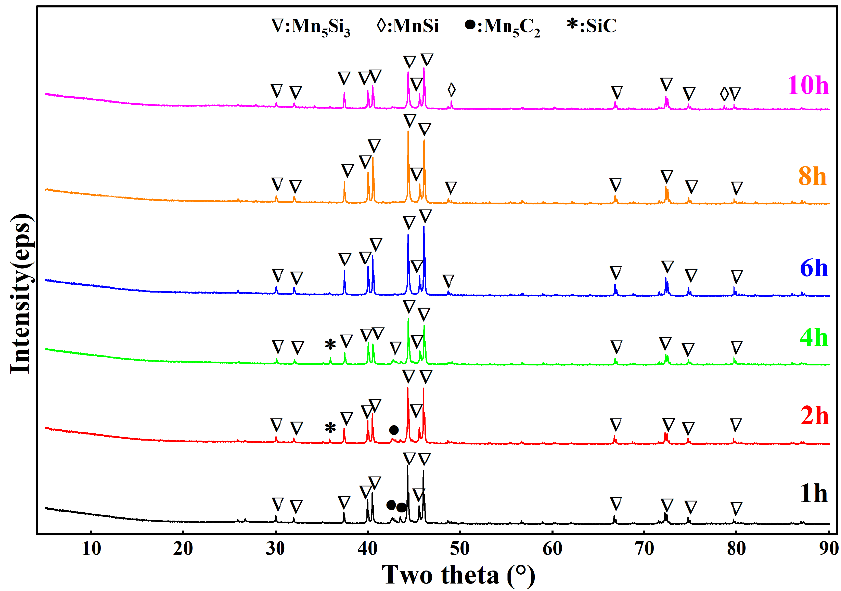
Figure 9. XRD patterns of the middle and lower alloys in the reduction residue with varying holding times.